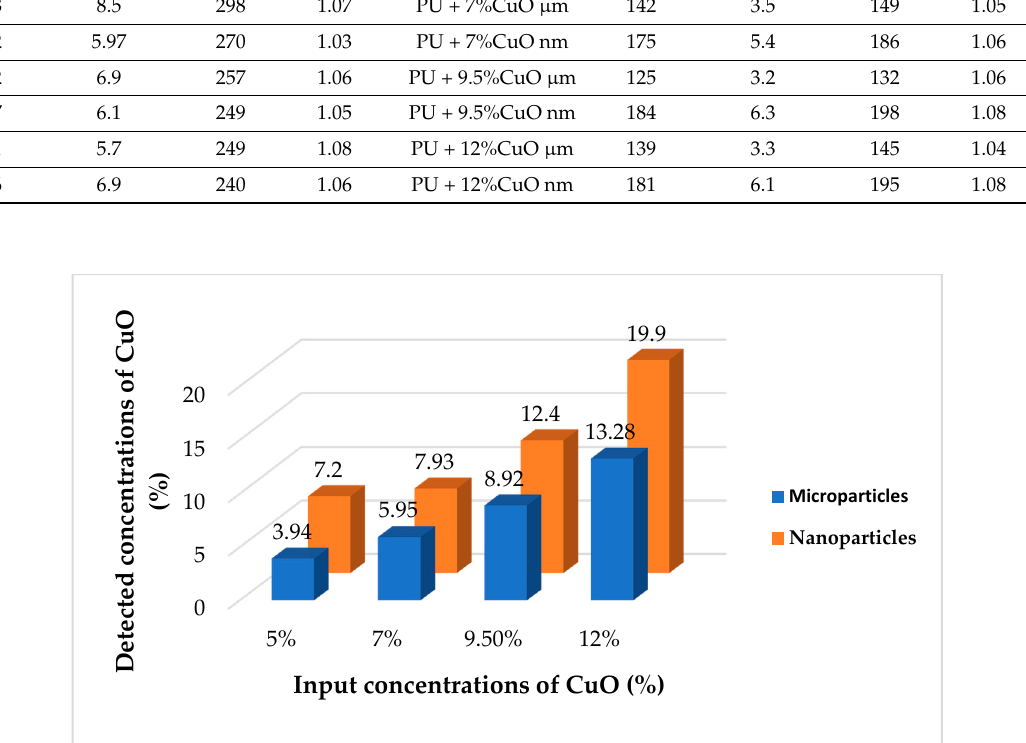
Figure 7. Difference between input and detected concentrations of micro- and nanoparticles of CuO for samples produced from the rotating electrode with needle surface provided by EDX analysis.